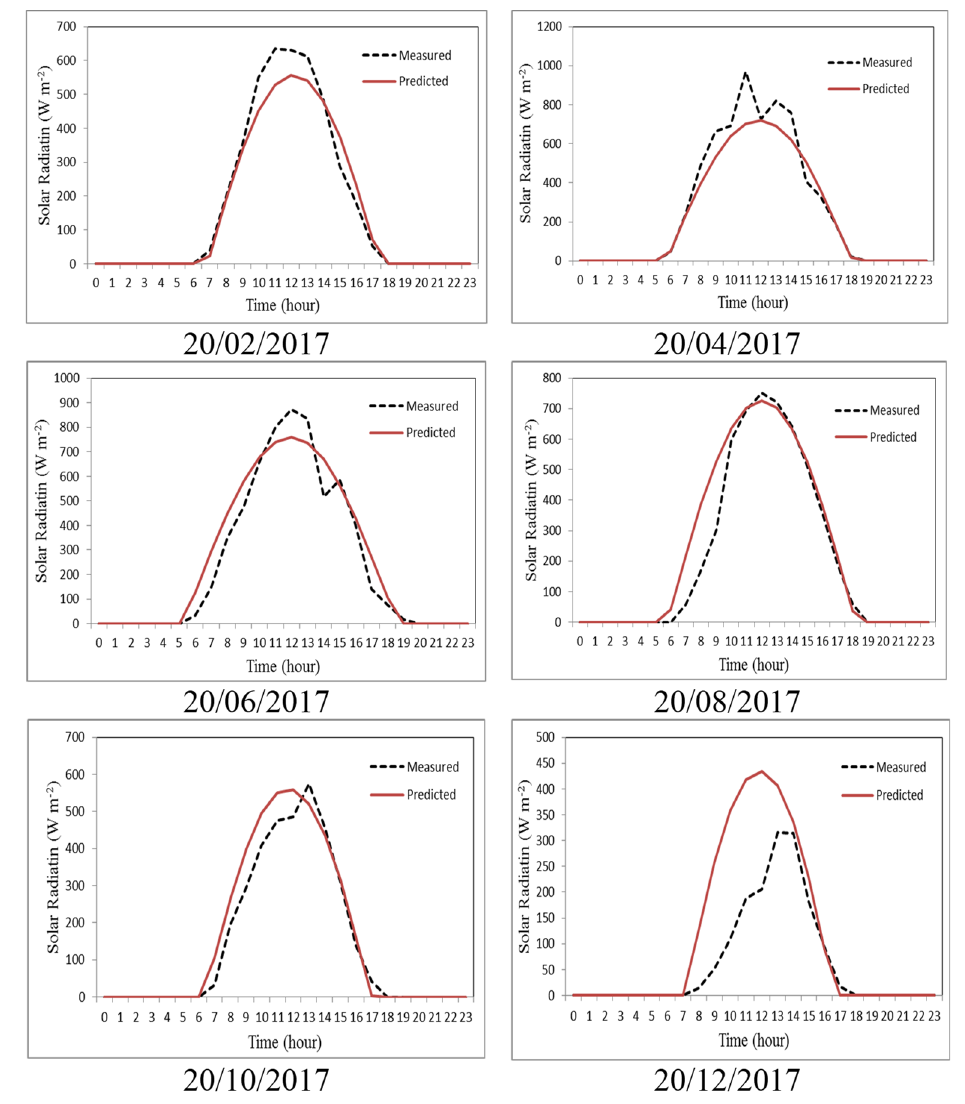
Figure 18. Predicted and measured hourly average solar radiation from solar collector.